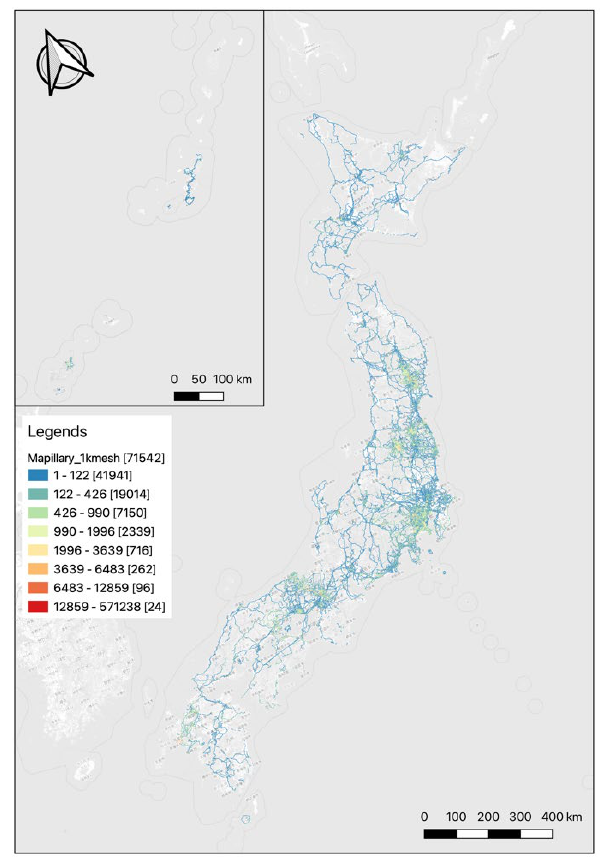
Figure 4. Number of Mapillary postings per user in each 1-km